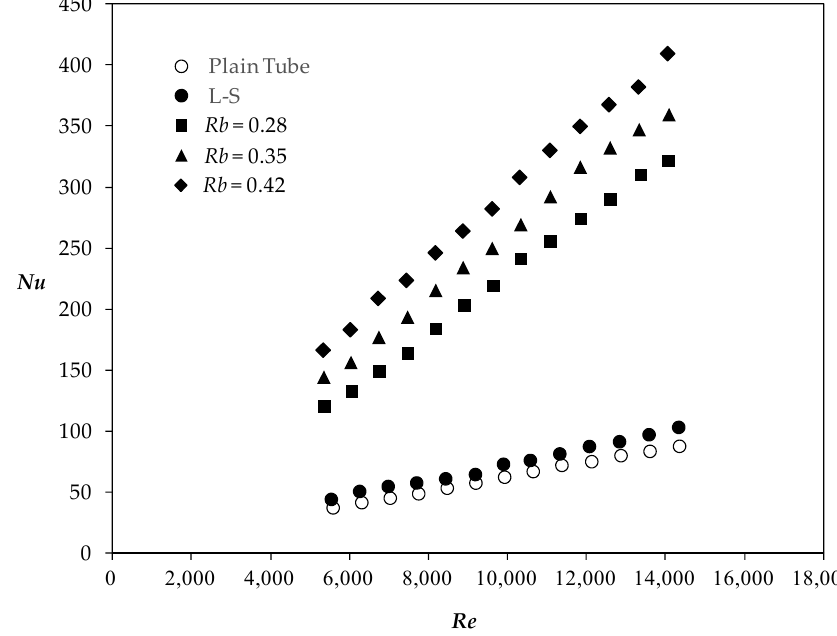
Figure 6. Effect of blockage ratio ( R b ) on convective heat-transfer behavior ( Nu ) with Reynolds number ( Re